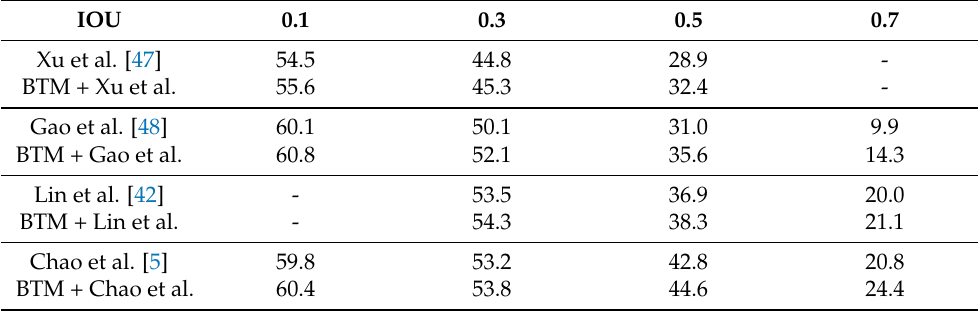
Figure 6. Verify the accuracy of the classification of various actions based on the action estimation network. Table 1. Temporal action detection results on